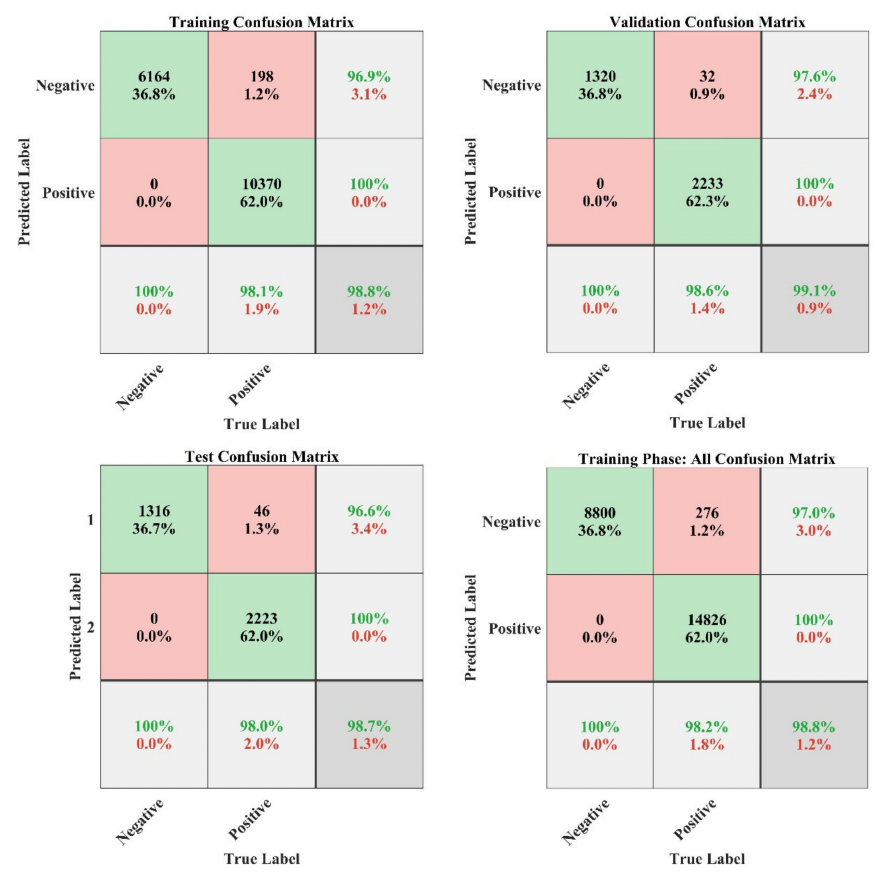
Figure 21. NN confusion matrix analysis plot for the training phase of the